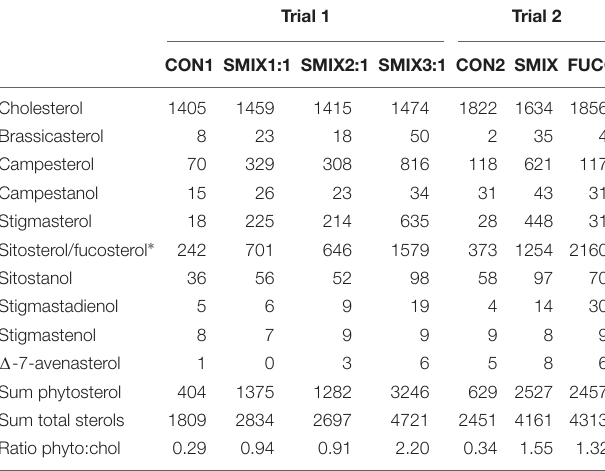
TABLE 3 | Analyzed sterol composition of diets ( µ g sterol per g